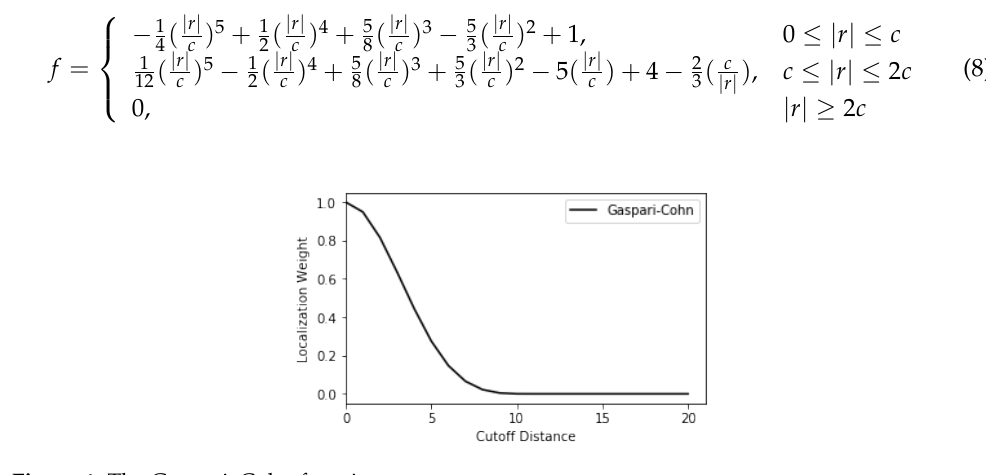
Figure 1. The Gaspari–Cohn